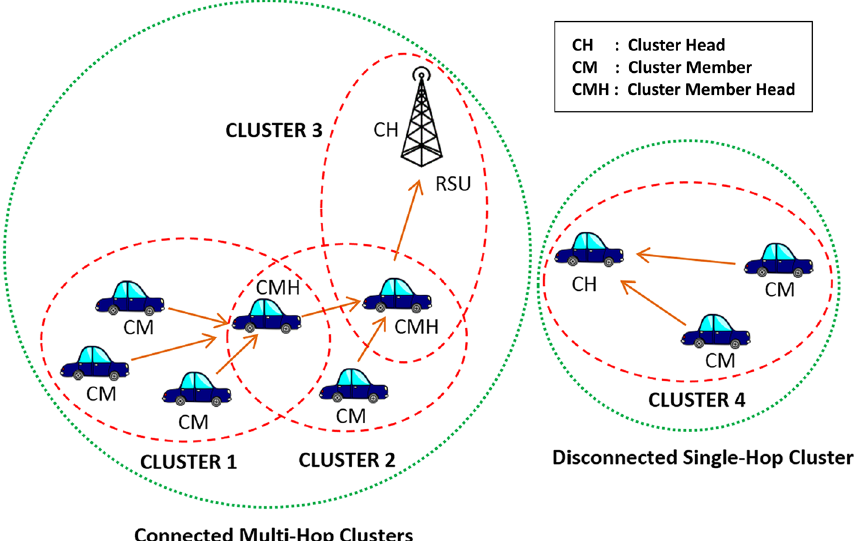
Fig. 1 Multi-hop clustering in a VANET with an